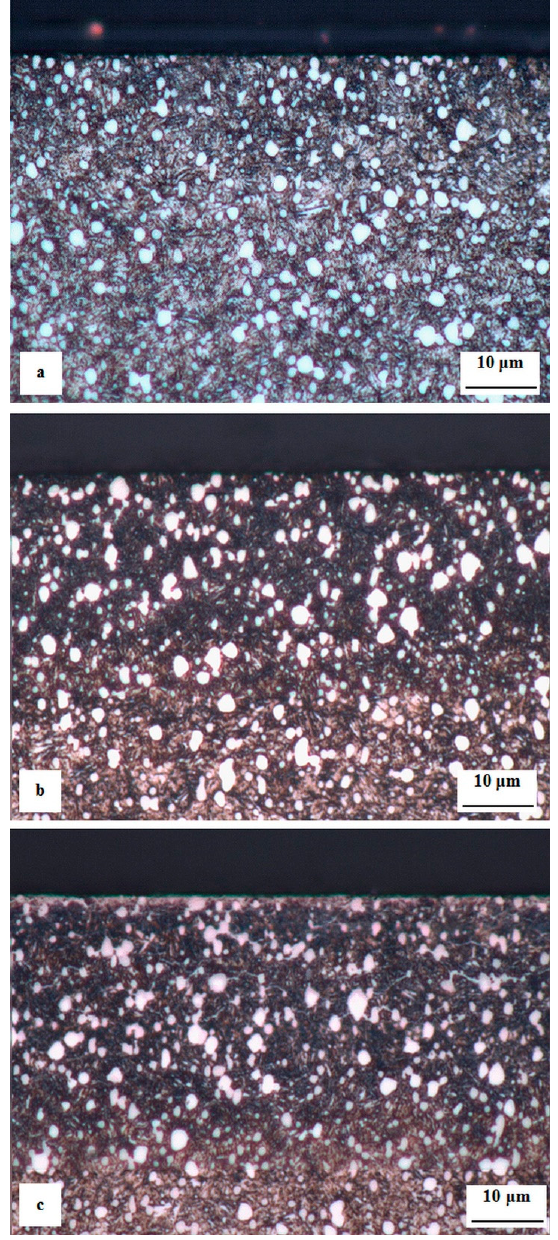
Figure 8. Optical micrographs showing the microstructures of differently plasma nitrided specimens: ( a ) Nitrided at 470 °C for 30 min, ( b ) nitrided at 500 °C for 60 min, and ( c ) nitrided at 530 °C for 120 min.